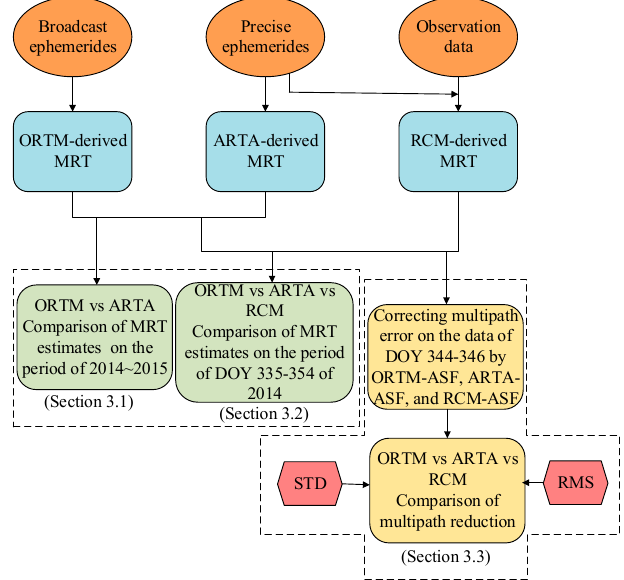
Figure 1. Flowchart of the comparison of MRT estimates derived by ORTM, ARTA, and